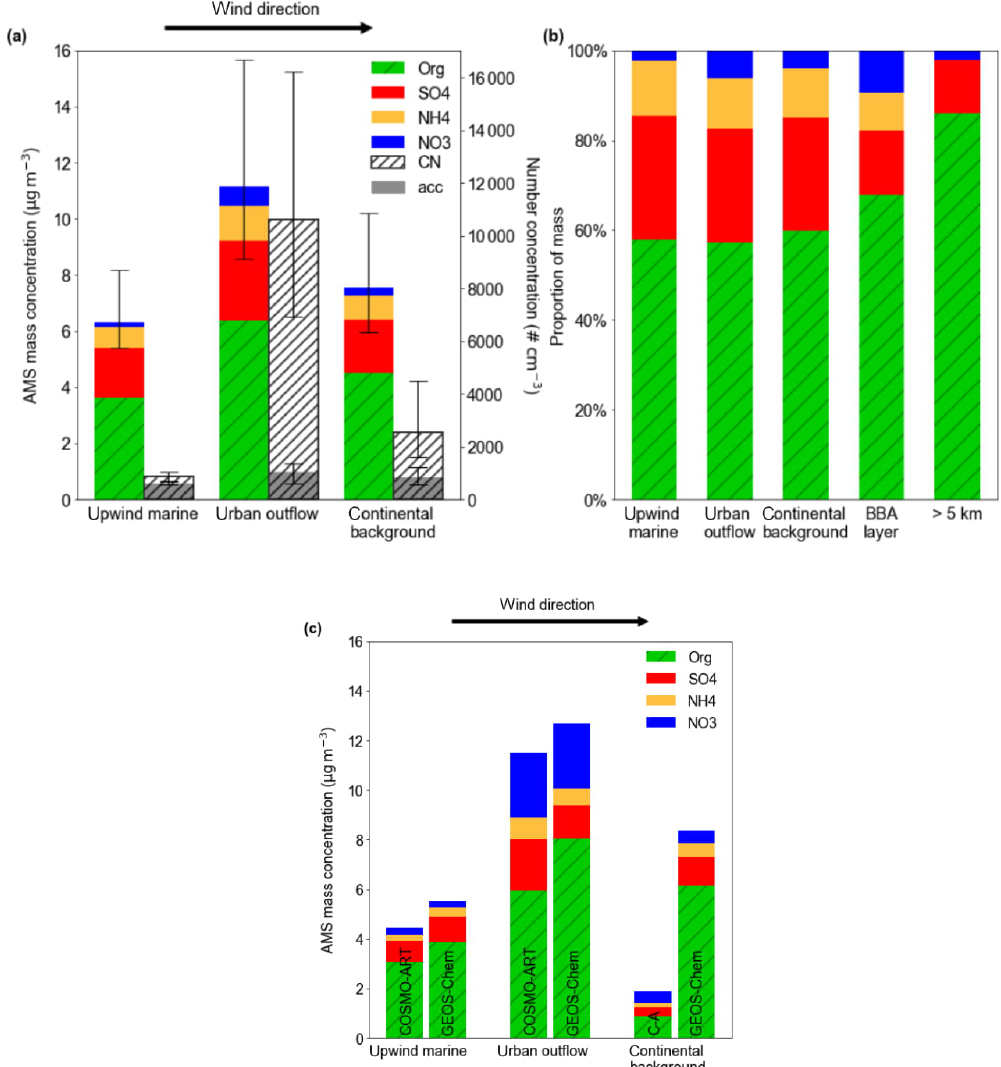
Figure 4. (a) The observed chemical composition and condensation nucleus (CN) concentration in each of the three regimes. Coloured bars indicate aerosol mass concentration measured by the AMS. The CN bars show the total aerosol number concentration in each location (measured by the CPC), with shaded regions indicating the number of aerosol particles in the accumulation mode (derived from SMPS data shown in Fig. 3). Bars indicate the median, with error bars showing the interquartile range of observations (for total aerosol in the case of the AMS). A similar chemical distribution can be seen in each of the three regimes. (b) A comparison of the aerosol chemical distribution in all three regimes, alongside observations from the biomass burning layer at 3–4km altitude (ATR and Falcon; labelled “BBA layer”) and the free troposphere (>5km; Falcon) for comparison. (c) Aerosol composition in the three regimes simulated by the COSMO-ART and GEOS-Chem